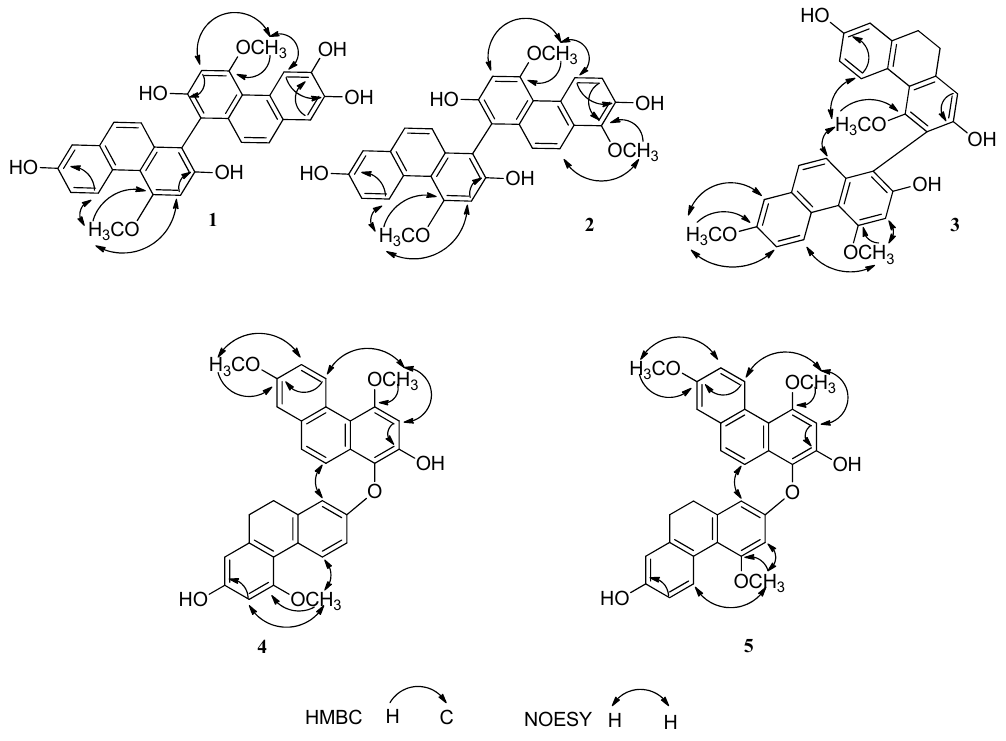
Figure 2. Key NOESY and HMBC correlations of compounds 1 – 5 . Table 1. 1 H-NMR Data of compounds 1 – 3 .